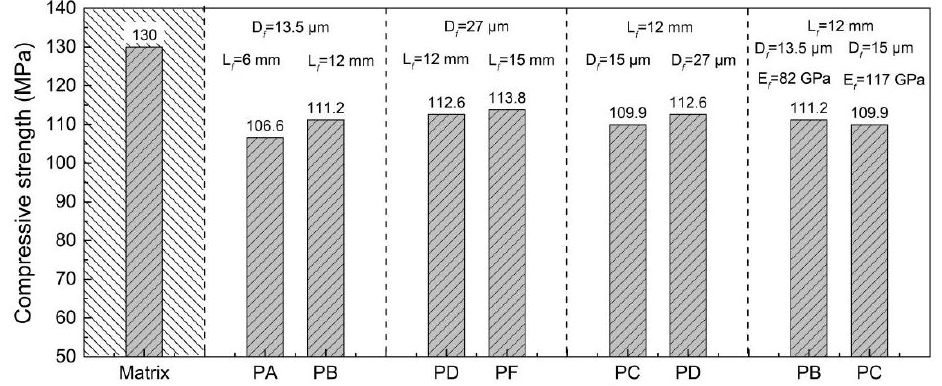
Figure 5 . Compressive strength of PE fiber reinforced UHPC. Figure 5. Compressive strength of PE fiber reinforced